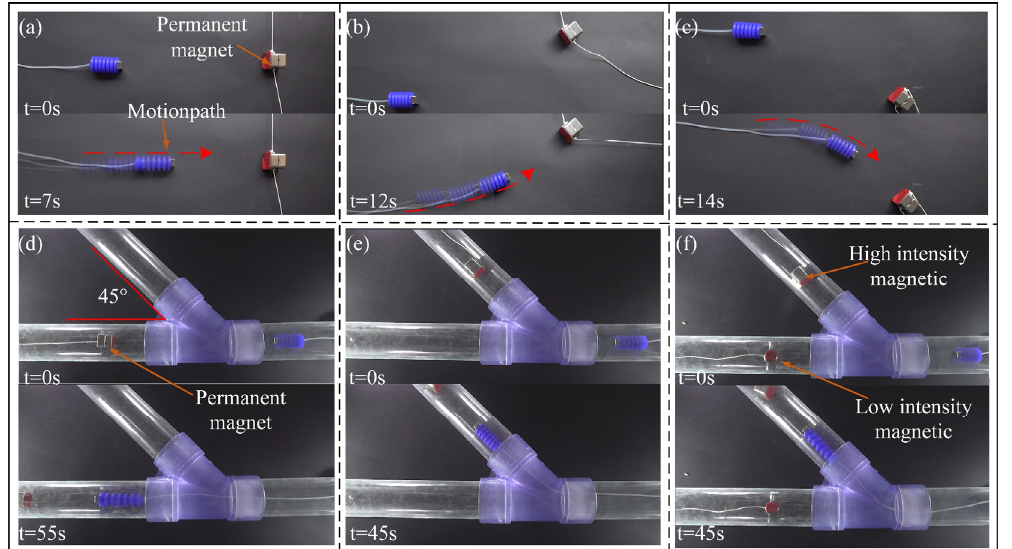
Figure 10. The magnetic navigation performance in different environments ( a ) Crawl in a straight line on the cardboard; ( b ) Turn left on the cardboard; ( c ) Turn right on the cardboard; ( d ) Crawl in a straight line on the pipeline; ( e ) Turn right on the pipeline; ( f ) Steering along the direction of the strong magnetic field under different magnetic field strengths.